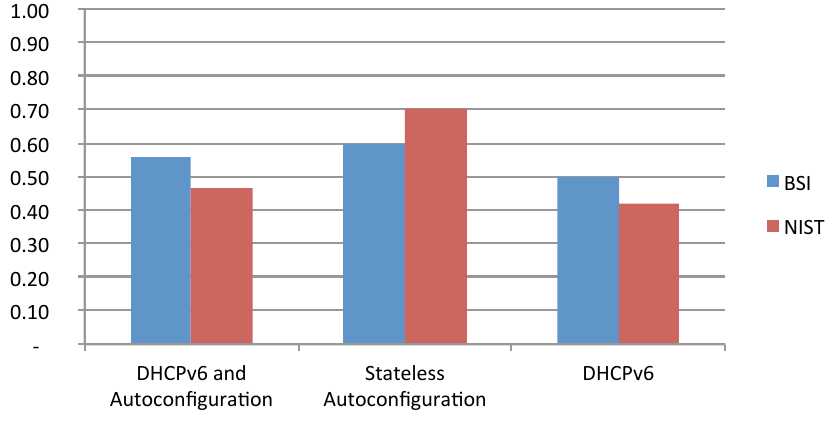
Figure 11. Average depth of DHCPv6 and